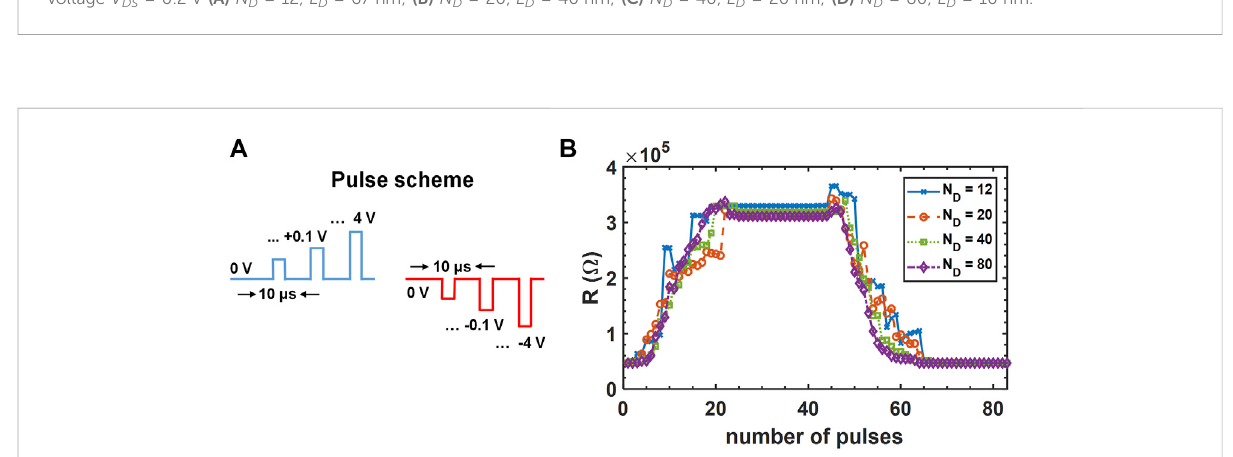
FIGURE 4 Simulated response of the WO x -based FeFET of Figure 1 to a train of electrical pulses (as shown in subplot (A) ) applied to the drain and source electrodes,whilethegateisgrounded.Thepulseamplitudeincreasesfrom0to4 Vandthendecreasesfrom0to − 4 V,withastepsizeof±0.1 Vand a period of 10 μ s. Different number of domains N D (from 12 to 80) at a constant standard deviation σ α 2 = − 0.3 μ α 2 are